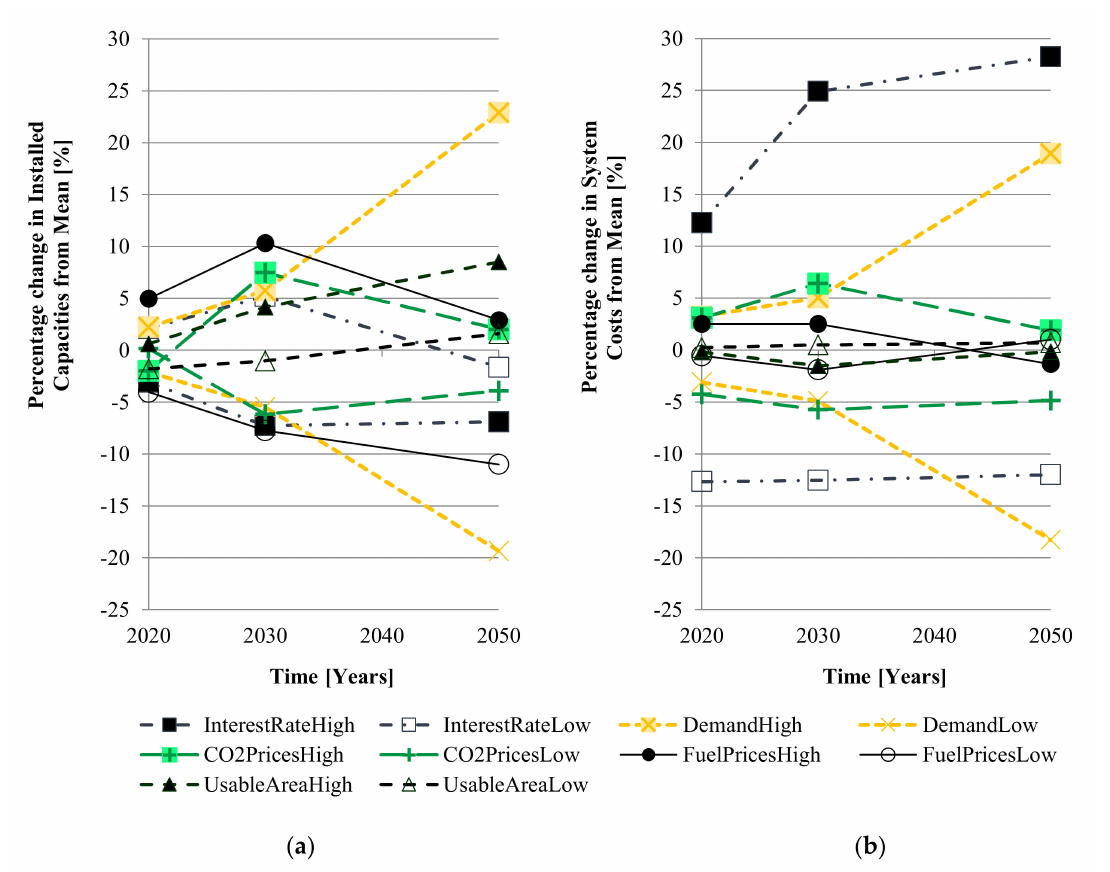
Figure 7. Sensitivity analyses: Variations in interest rate, demand, CO 2 -certificate prices, fuel prices, and usable areas for renewable-energy-technology deployment. ( a ) installed capacities relative to mean. ( b ) system costs relative to